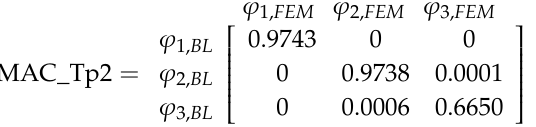
( b ) Figure 13. Eight-storey benchmark. Santa Venerina earthquake. Displacements time history along the ( a ) x and ( b ) y direction.